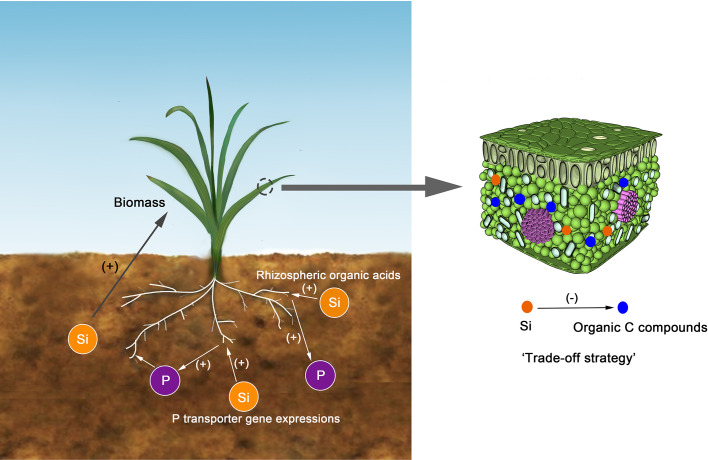
The conceptual model for the relationships between Si and C or P. The Si could substitute come organic carbon compounds, such as lignin. The Si could enhance P bioavailability in soils through regulating P transporter gene expressions or improving rhizospheric organic acids. The soil Si could enhance the biomass of plants and then positively influences the C, N, and P accumulations.